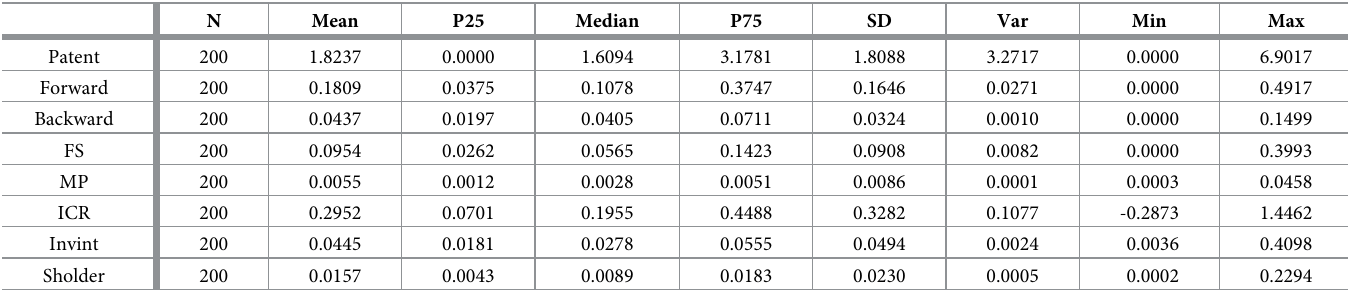
Table 2. Descriptive statistics on listed Chinese coal